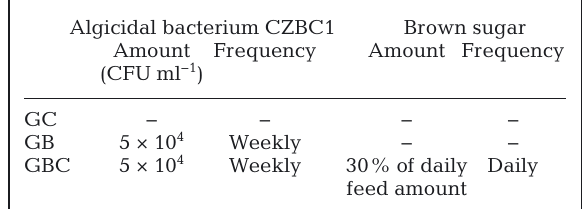
Table 1. Experimental treatments examining the effect of adding algicidal bacteria (CZBC1) and carbon (brown sugar) on performance of Litopenaeus vannamei (GC: control; GB: bacteria; GBC: bacteria− carbon). CFU: colony forming